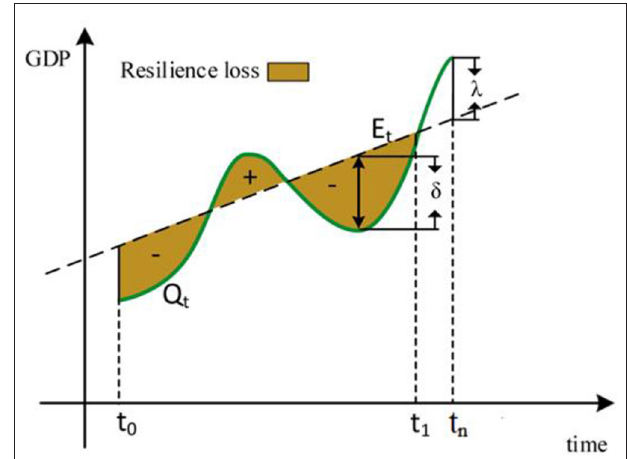
FIGURE 1 | Resilience assessment of post-disruption